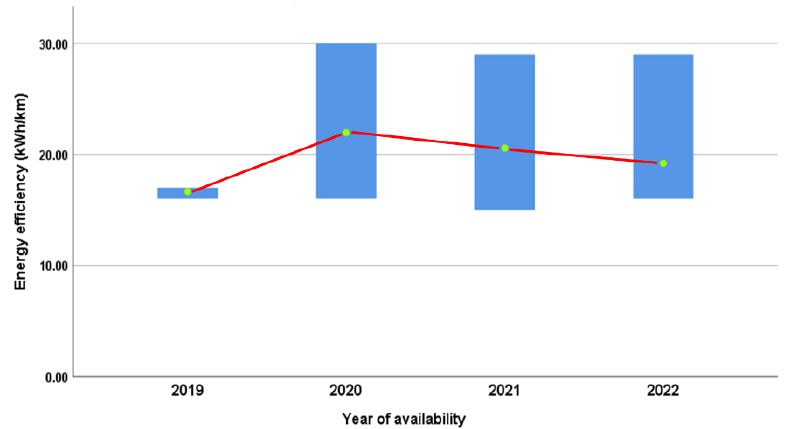
Figure 6. Range bar variation (min, max, mean) representation of battery’s energetic capacity vs. year of availability in market.